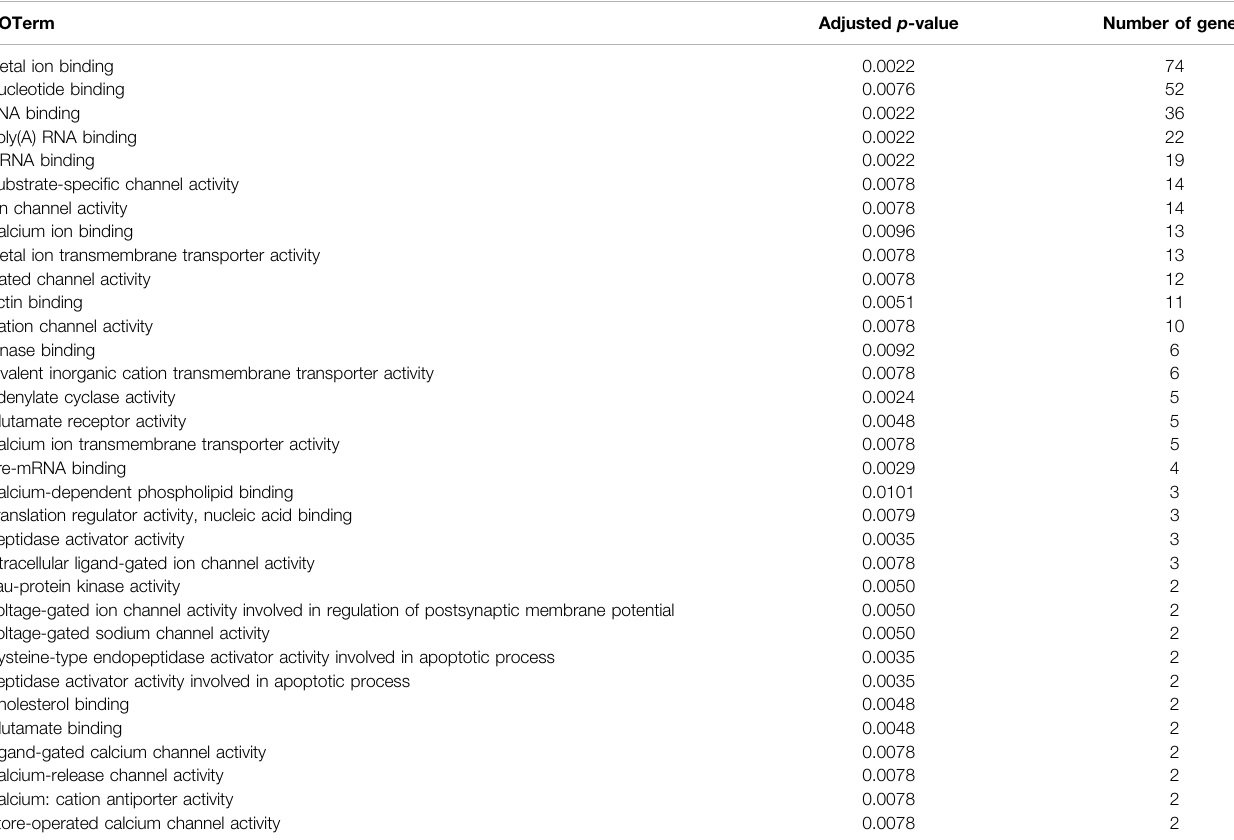
TABLE 3 | GO term analysis for AS-NMD regulated genes in Drosophila . GOTerm